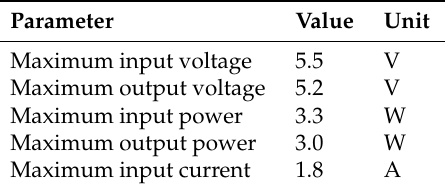
Table 2. Maximum electrical ratings of the selected MPPT.